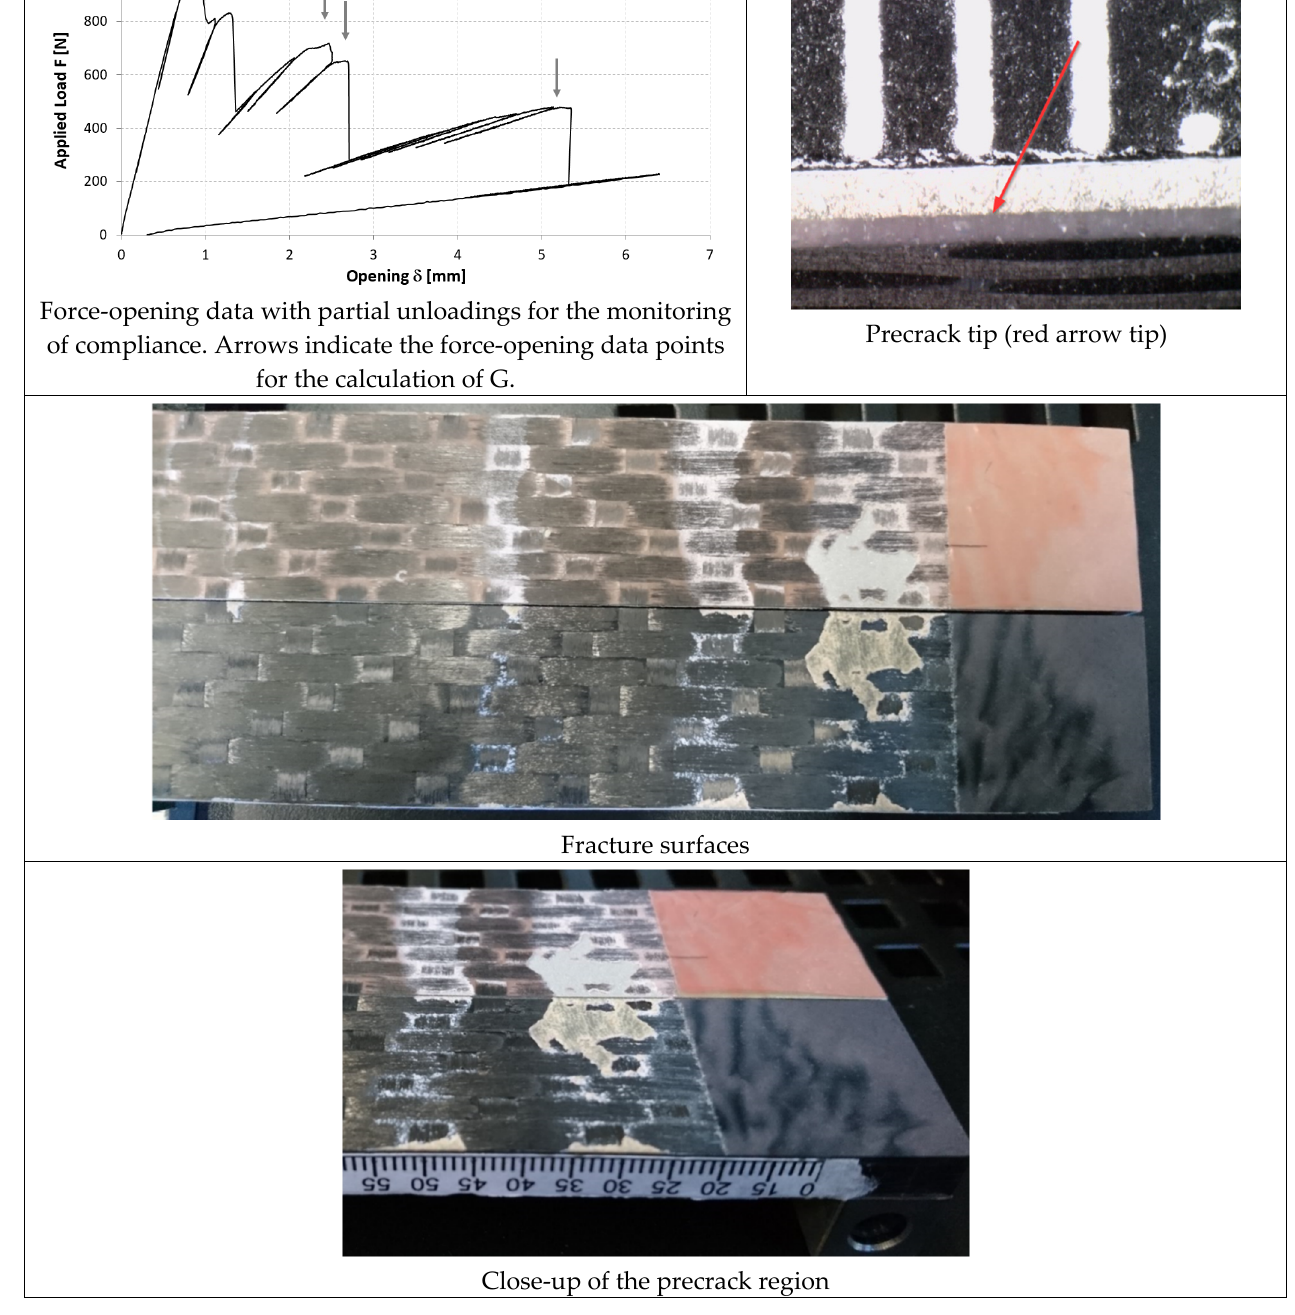
Figure 17. Results of the test on specimen DCB_9323_01.